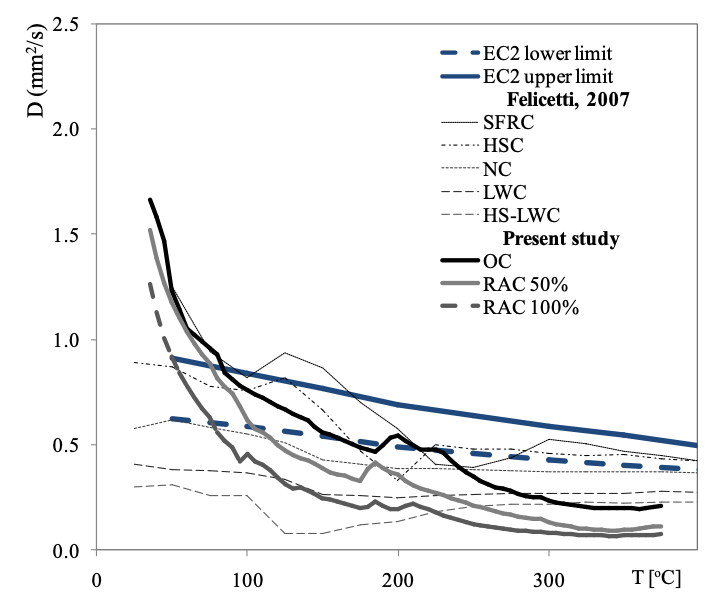
Figure 3. Equivalent thermal di ff usivity for OC, RAC 50% and RAC 100%compared with the results of Felicetti [11] and EC 2 proposed